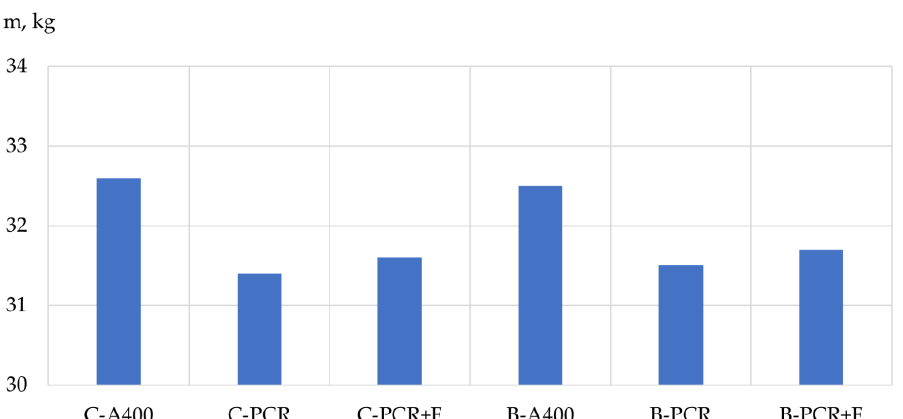
Figure 5. Dependence of the mass of the prototype columns and specimen beams on the type of reinforcement used: C-A400 is the sample column reinforced with steel reinforcement of class A400; C-PCR is a sample column reinforced with polymer composite reinforcement; C-PCR+F is a sample column reinforced with polymer composite reinforcement and glass fiber; B-A400 is a sample beam reinforced with steel reinforcement class A400; B-PCR is a sample beam reinforced with polymer composite reinforcement; B-PCR+F is a sample beam reinforced with polymer composite reinforce- ment and glass fiber.